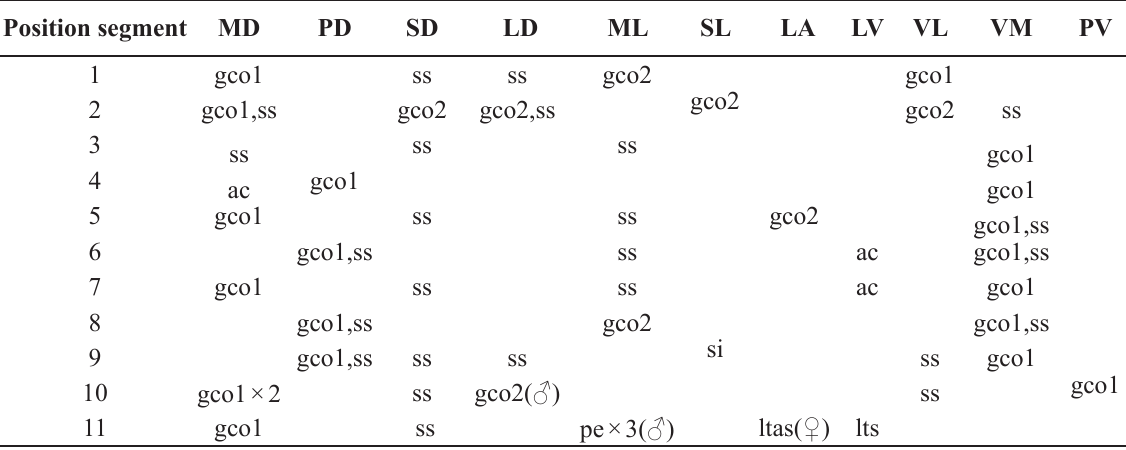
Table 27. Summary of nature and location of sensory spots, glandular cell outlets, tubes and spines arranged by series in Echinoderes sp. aff. E. unispinosus